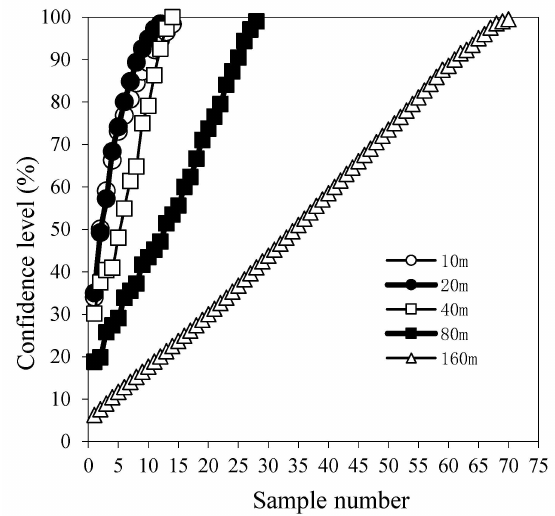
Figure 4. Relationship between the sample number and the confidence level at the 10 m, 20 m, 40 m, 80 m, and 160 m scales at a relative error of